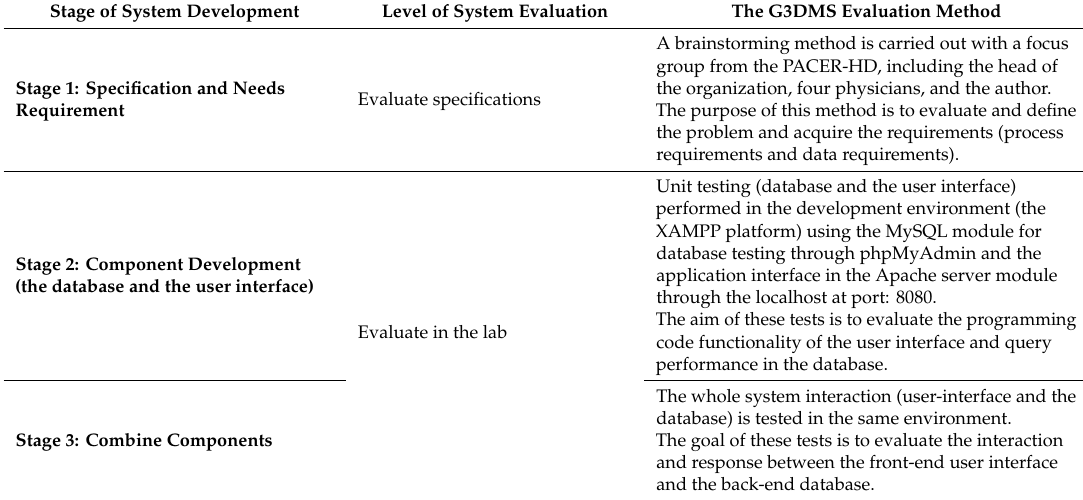
Table 5. The informatics evaluation framework for the